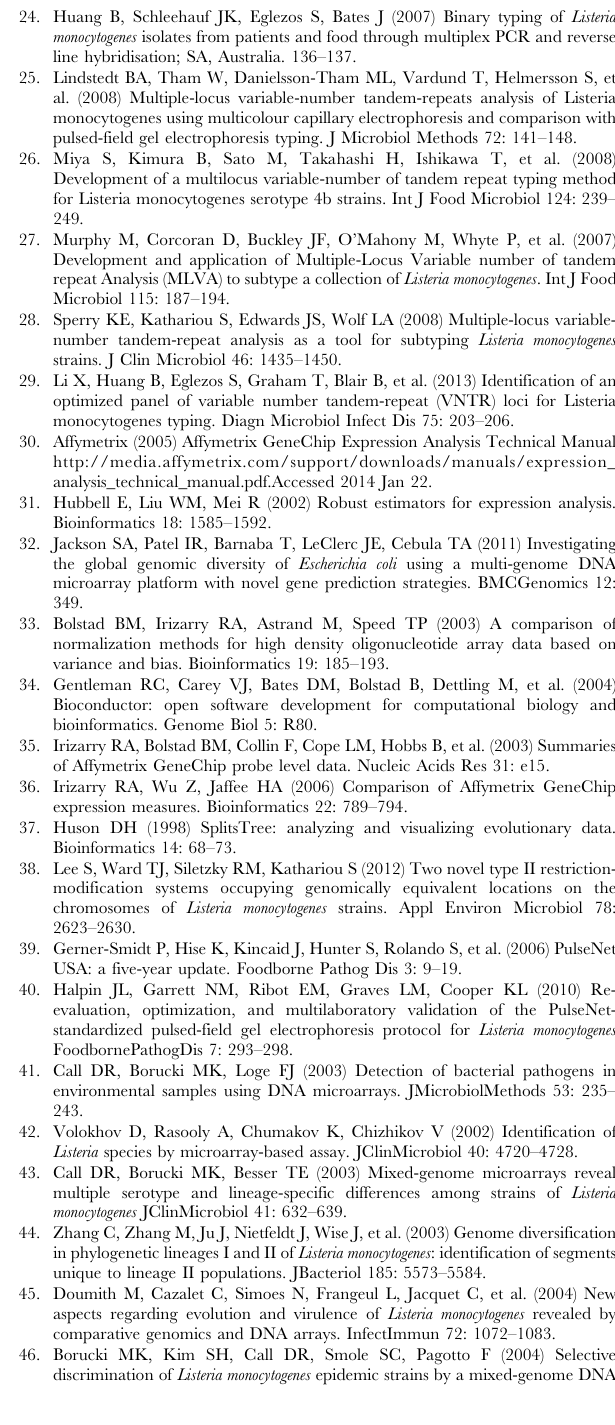
Table S1 Probe-sets uniquely present in LS642 and absent in LS643, LS644 and LS645.